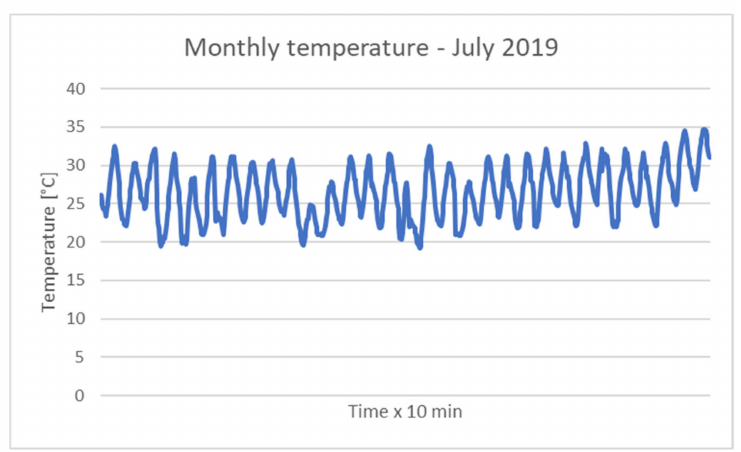
Figure 8. Monthly measured temperature for July 2019.